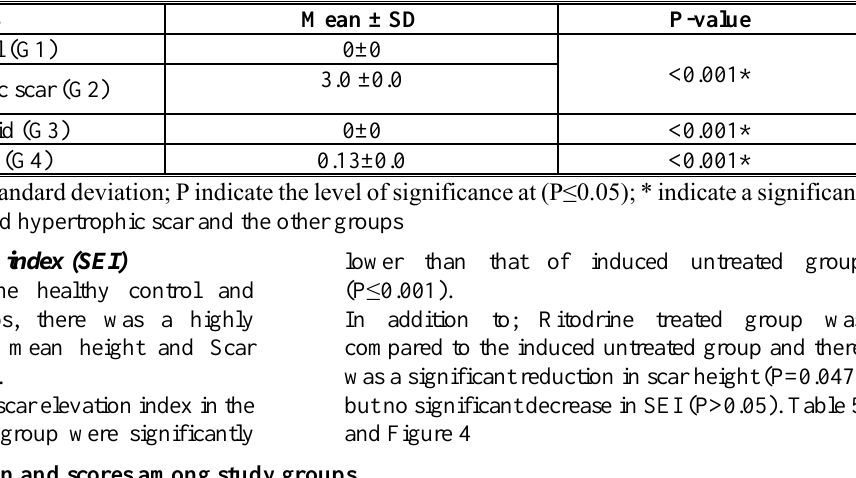
Table 5. Scores evaluation and scores among study groups Parameters